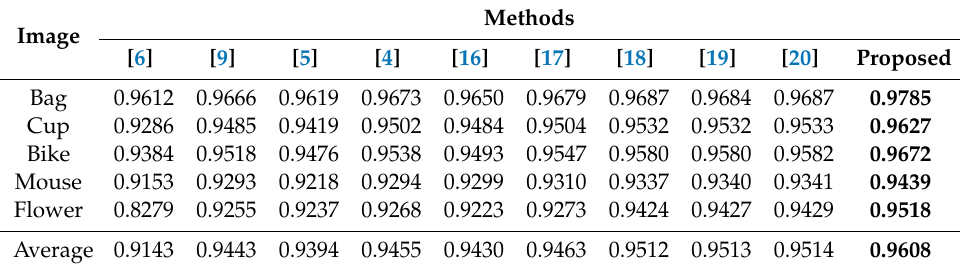
Table 7. The performance summary of di ff erent methods on the five image datasets, using